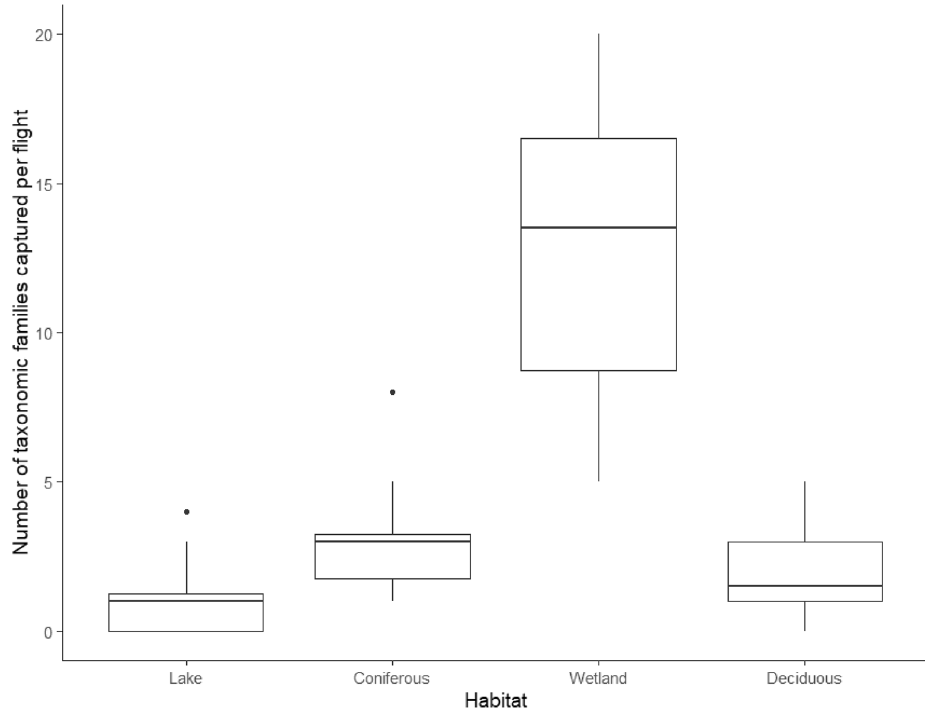
Figure 5. Boxplot of insect and arthropod families for the four study habitats collected after one 3-min drone flight with canopy contact. Boxes indicate median, first and third quartile, as well as minimum and maximum